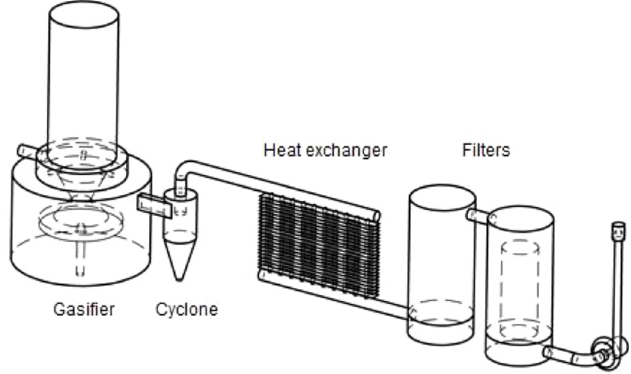
Fig. 5. The gasi fi er and gas cleaning system.